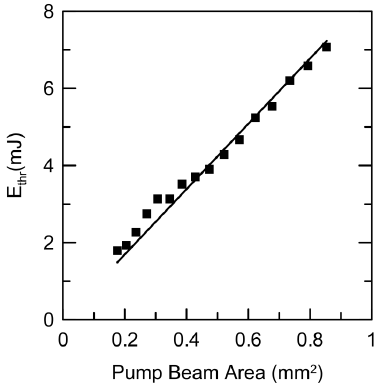
Figure 6. Threshold pump energy for Nd:YAG crystal powder as a function of pump beam area. As can be seen, the threshold energy fits well a linear function; therefore, the threshold energy density is